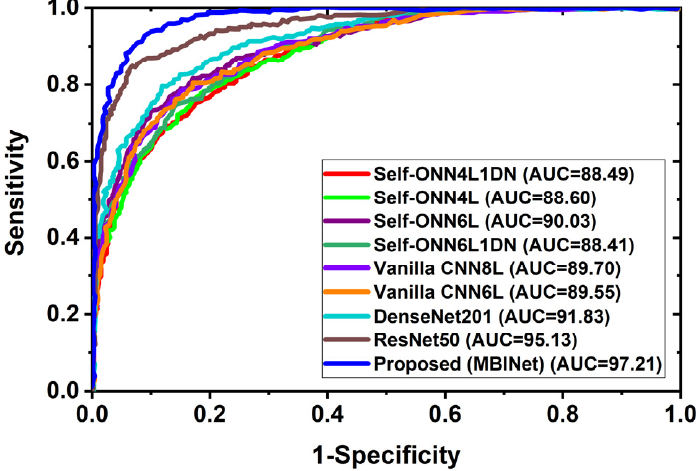
Figure 9. Receiver Operating Characteristics (ROC) curve with AUC.